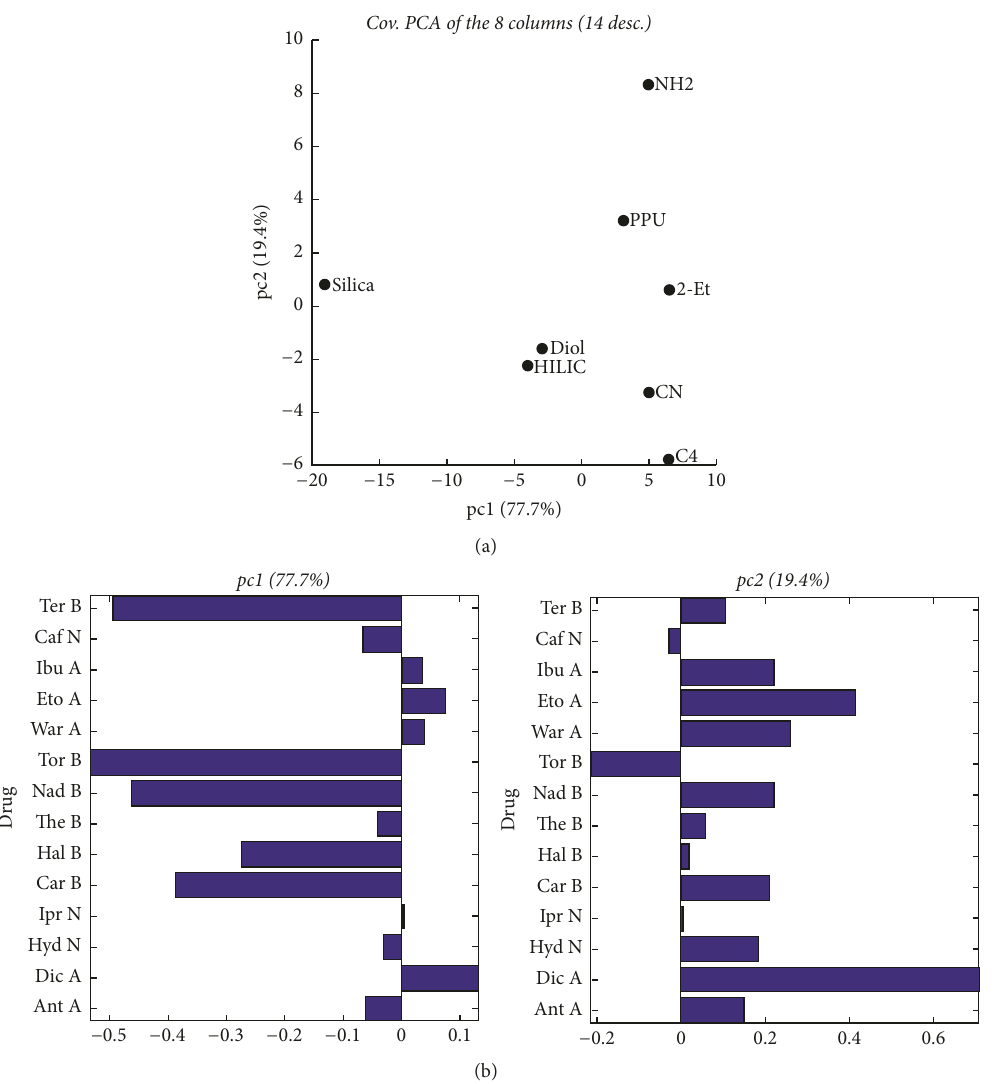
Figure 2: (a) Score plot as generated by PCA for the 8 × 14 matrix (8 columns described by 14 drugs in the central condition only). (b) Loadings of the 8 × 14 matrix (8 columns described by 14 drugs in the central condition only).